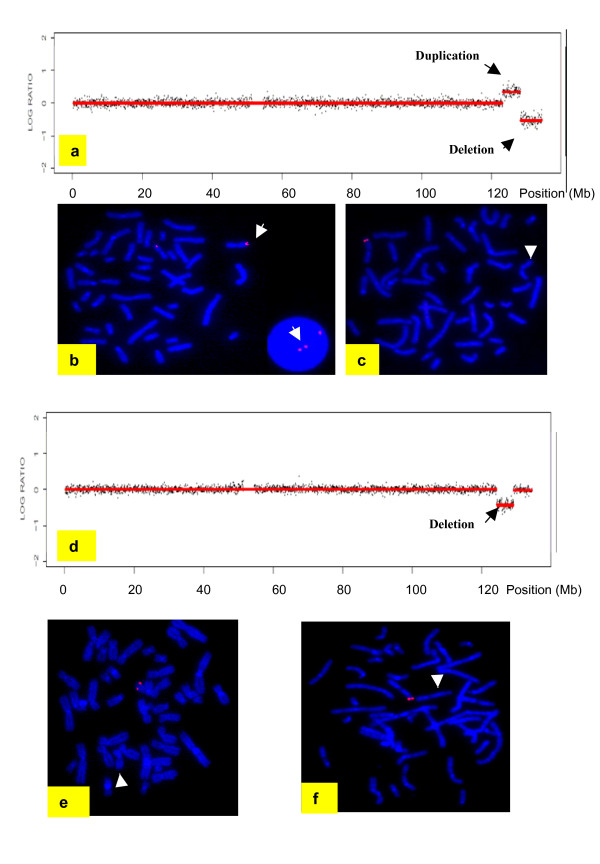
11q24-25 rearrangements found in subjects 1 and 2. (a) Nimblegen array (385 K) profiles of chromosome 11 showed a 5.04 Mb duplication and a 6.18 Mb deletion detected in subject 1. FISH confirmation of the duplication of clone RP11-50B3 (b) and deletion of clone RP11-206H19 (AP003775.3) (c) in subject 1. (d) Nimblegen array (385 K) profiles of chromosome 11 showed a 4.74 Mb deletion of chromosome 11q24.2-24.3 in subject 2. FISH confirmation of the deletion of clones RP11-50B3 and RP11-206H19 (AP003775.3) in subject 2 is shown in (e) and (f), respectively. Arrow indicates duplicated chromosome and arrowhead the deleted chromosomes.